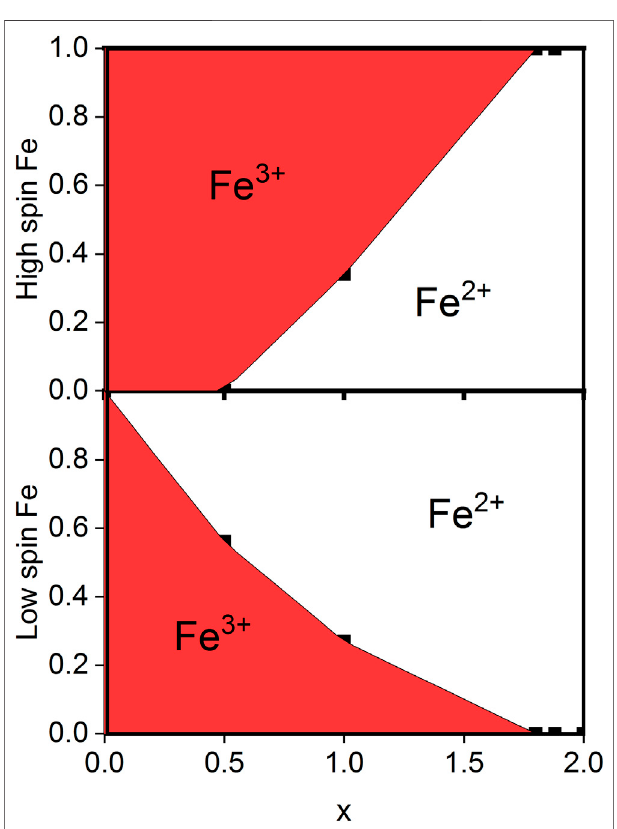
FIGURE 2 | Valence distribution found for Na x Fe [Fe(CN) 6 ].1.8H 2 O for varying x -values.At x =0,allFeonbothsitesareFe 3+ ,whileat x > 1.8,allFeon both sites are Fe 2+ . Data are measured at 90